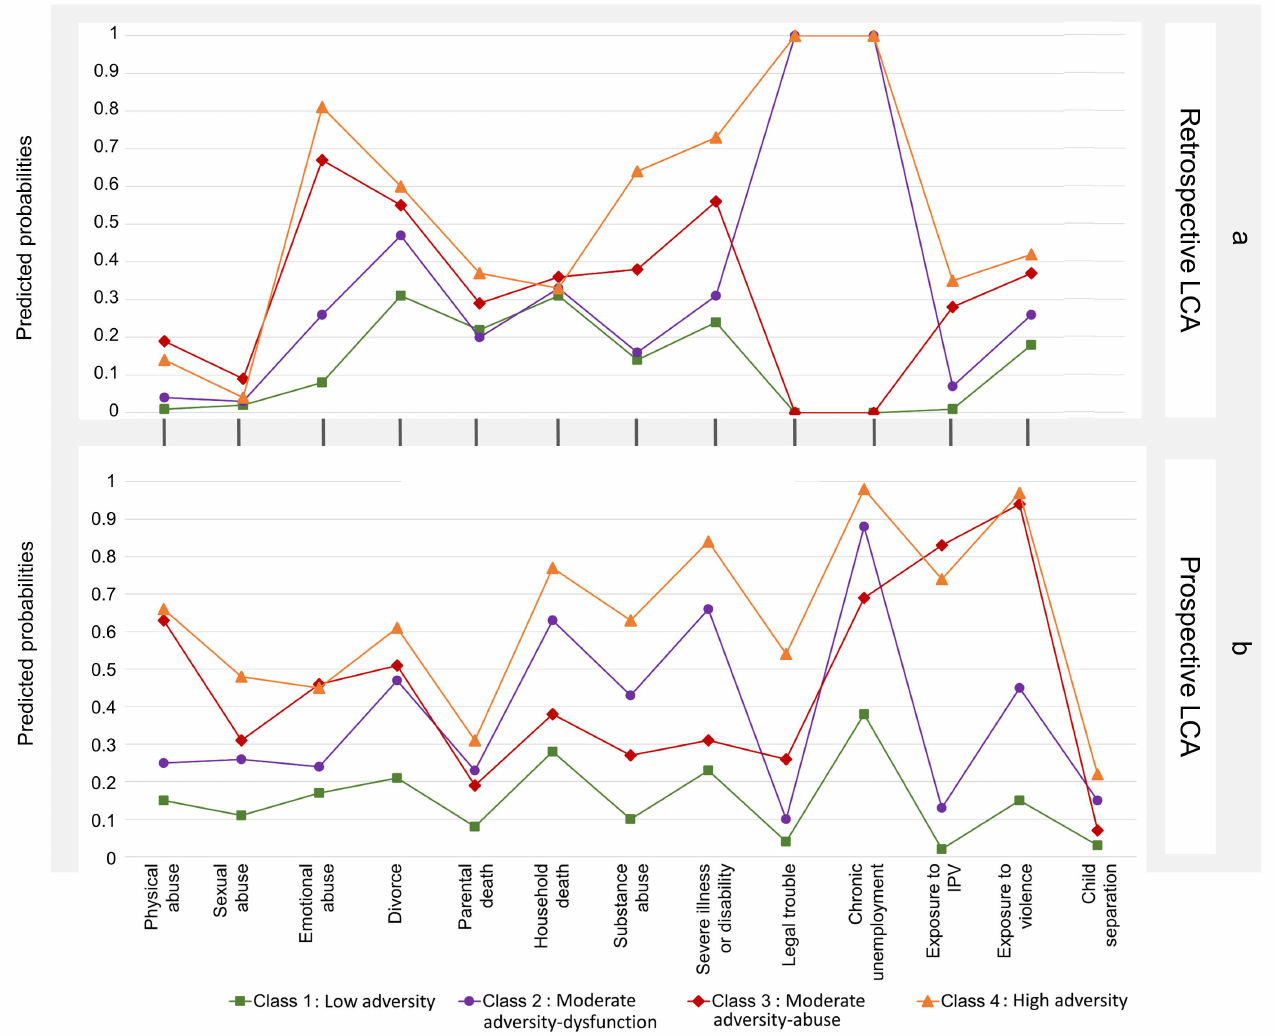
Figure 1. Predicted probabilities for latent class analyses of: ( a ) retrospective ACEs; ( b ) prospective